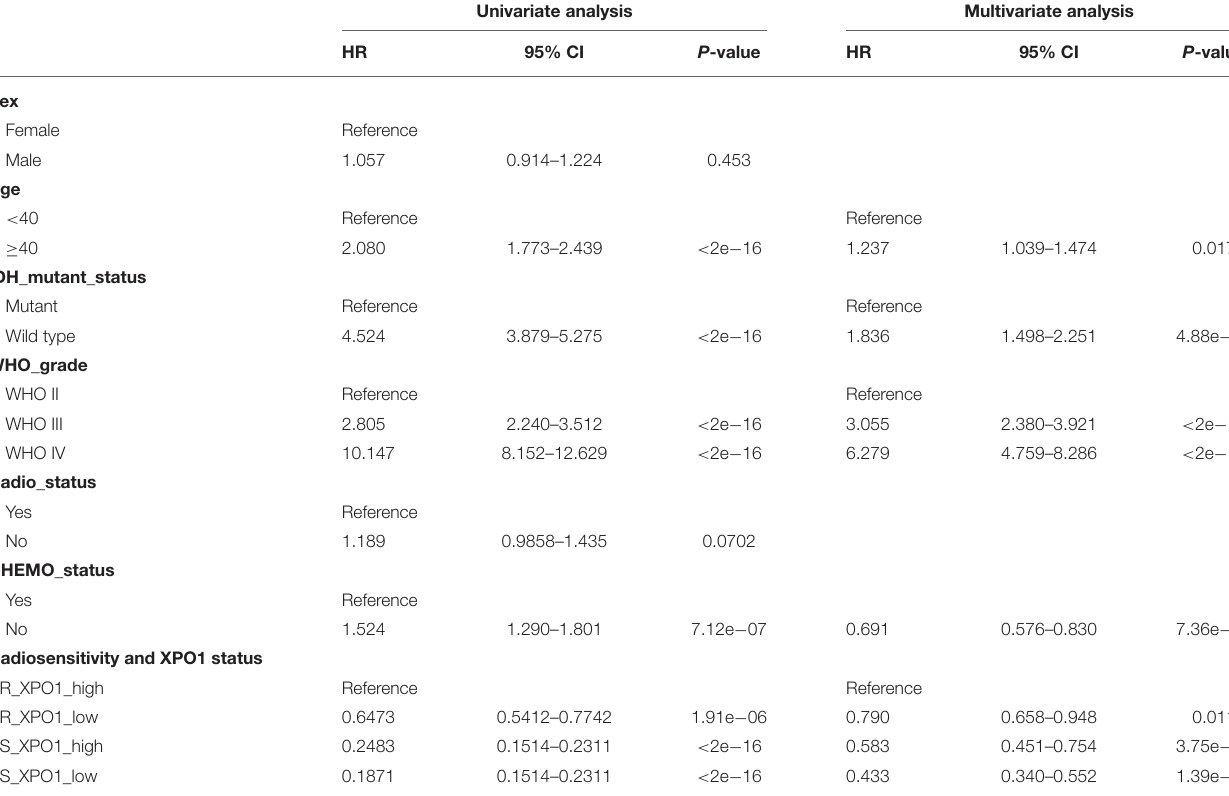
TABLE 3 | Univariate analysis and multivariate analysis of patients.